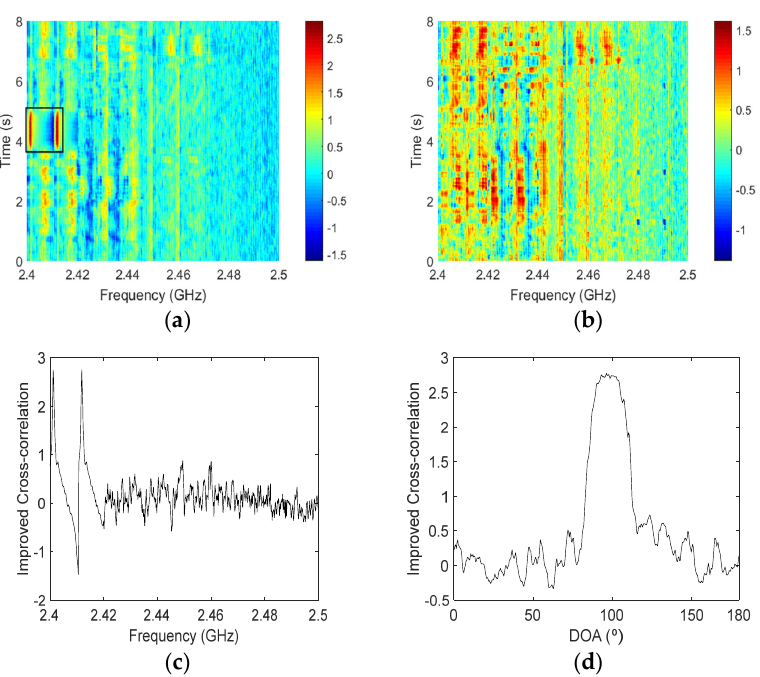
Figure 5. ( a ) The improved cross-correlation using accumulation with the UAV present, ( b ) the improved cross-correlation using accumulation with no UAV present, ( c ) frequency estimation with a UAV present, and ( d ) direction of arrival (DOA) estimation at frequency f start